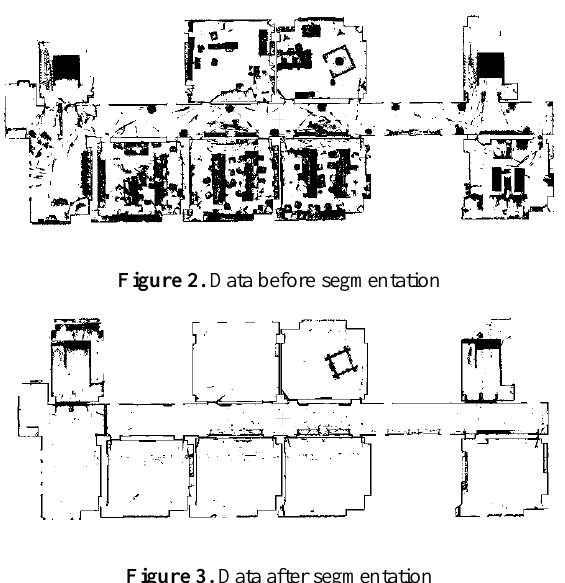
Figure 3. Data after